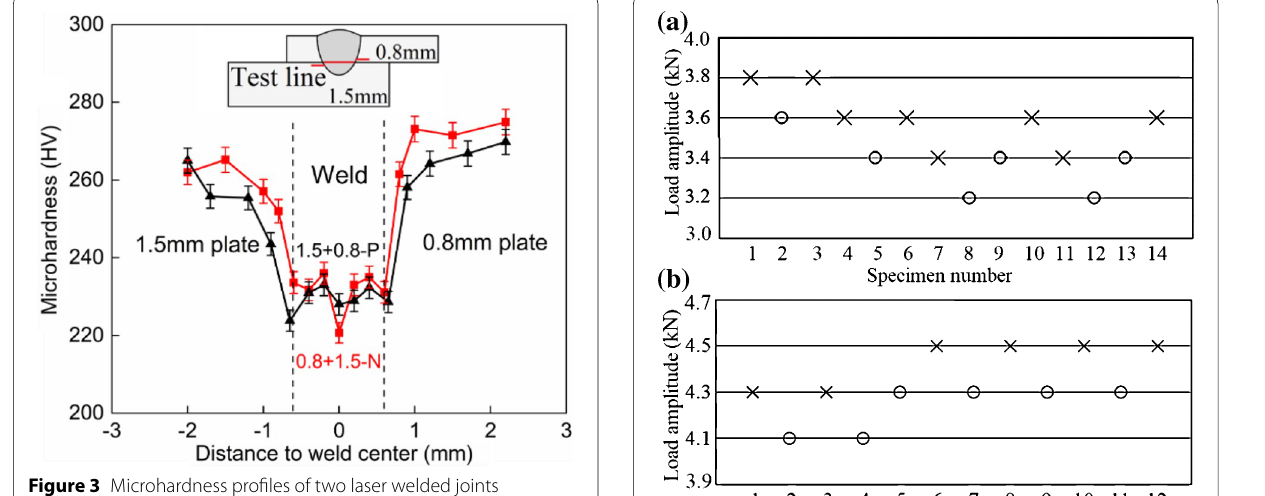
Figure 5 Fatigue lift charts of a 0.8